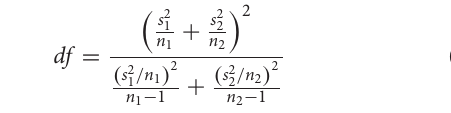
TABLE 1 | Demographic characteristics for the OASIS3 dataset. Characteristics